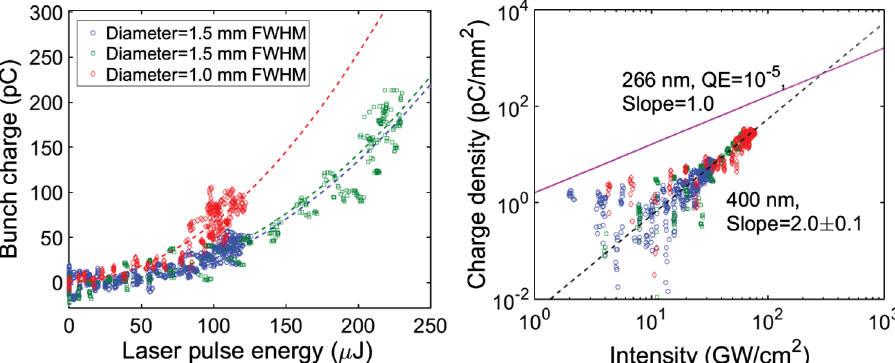
FIG. 3. Electron bunch charge and absorbed laser intensity. (a) Incident laser pulse energy E vs electron bunch charge. (b) Incident laser intensity I vs electron charge density. The large scatter of data points mainly comes from the time jitter between the laser pulses and rf field inside the gun, it also comes from the amplitude and phase noise from the rf field itself. Both of them can change the instant field at the cathode, and change the QEs, thus the charges of electron bunches. Because this is an X -band photoinjector, therefore it is more sensitive to the phase noise compared to the traditional S-band photoinjectors. Meanwhile, the jittering of rf field changes the effective work function of the copper cathode, and also contributes to the large scatter of data in Figs. 3 and 4.